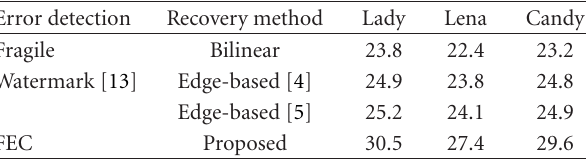
Table 3: Comparisons with other error concealment algorithms for ROI image recovery.